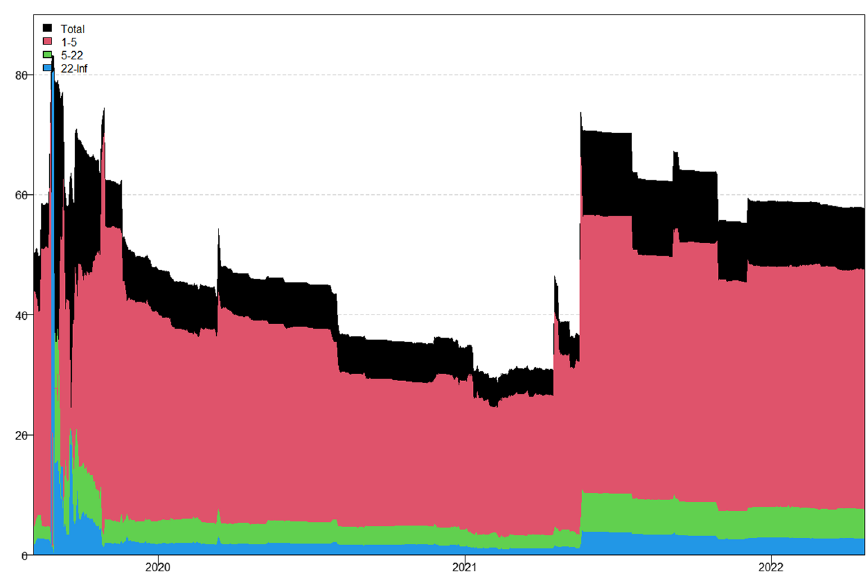
Fig. 35 Dynamic total SJV connectedness—robustness check